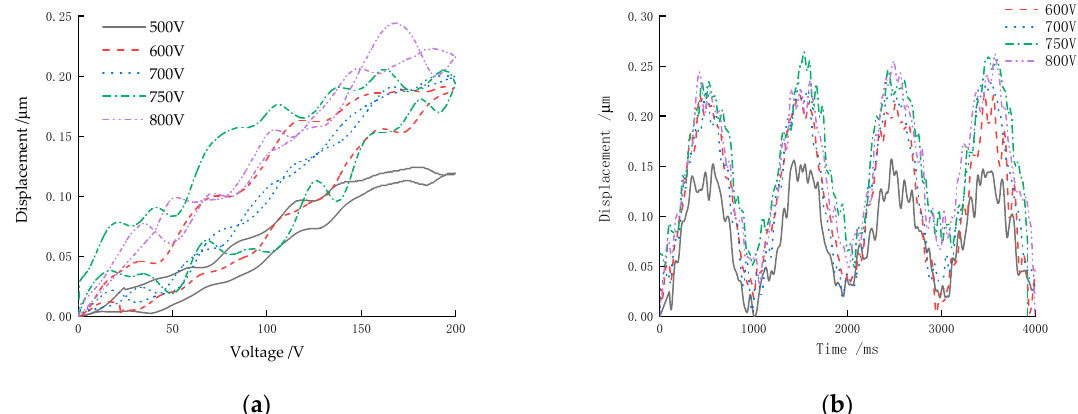
Figure 12. Displacement versus the polarization voltage: ( a ) response curves; ( b ) time-domain curves (four cycles).